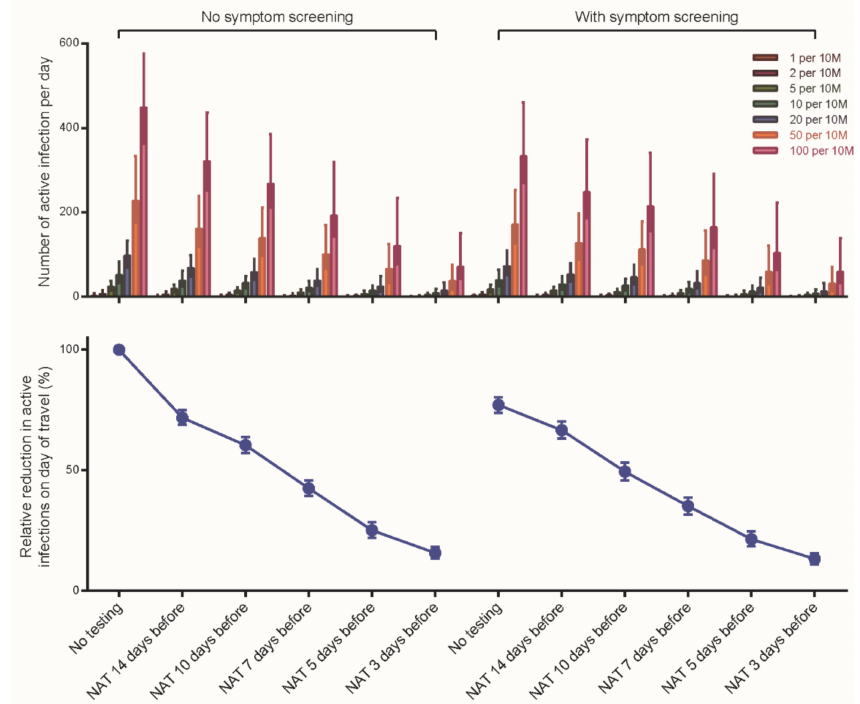
Figure 1. Predicted number of active infections on the day of travel by different testing strategies. We estimated the number of active infections on the day of travel (vertical axis) with simulation of each testing strategy (grouped horizontal axis). The height of the histogram represented the mean and the error bars represented by the 95% confidence interval (95% CI) across 1000 simulations. Each testing strategy was compared under circumstances with or without symptom screening. A sensitivity analysis that was conducted by changing daily incidence varied from 1 to 100 per 10,000,000 persons. Relative reduction in active infections on day of travel by each testing strategy is shown in bottom panel. NAT—nucleic acid testing. 10 M—10 million